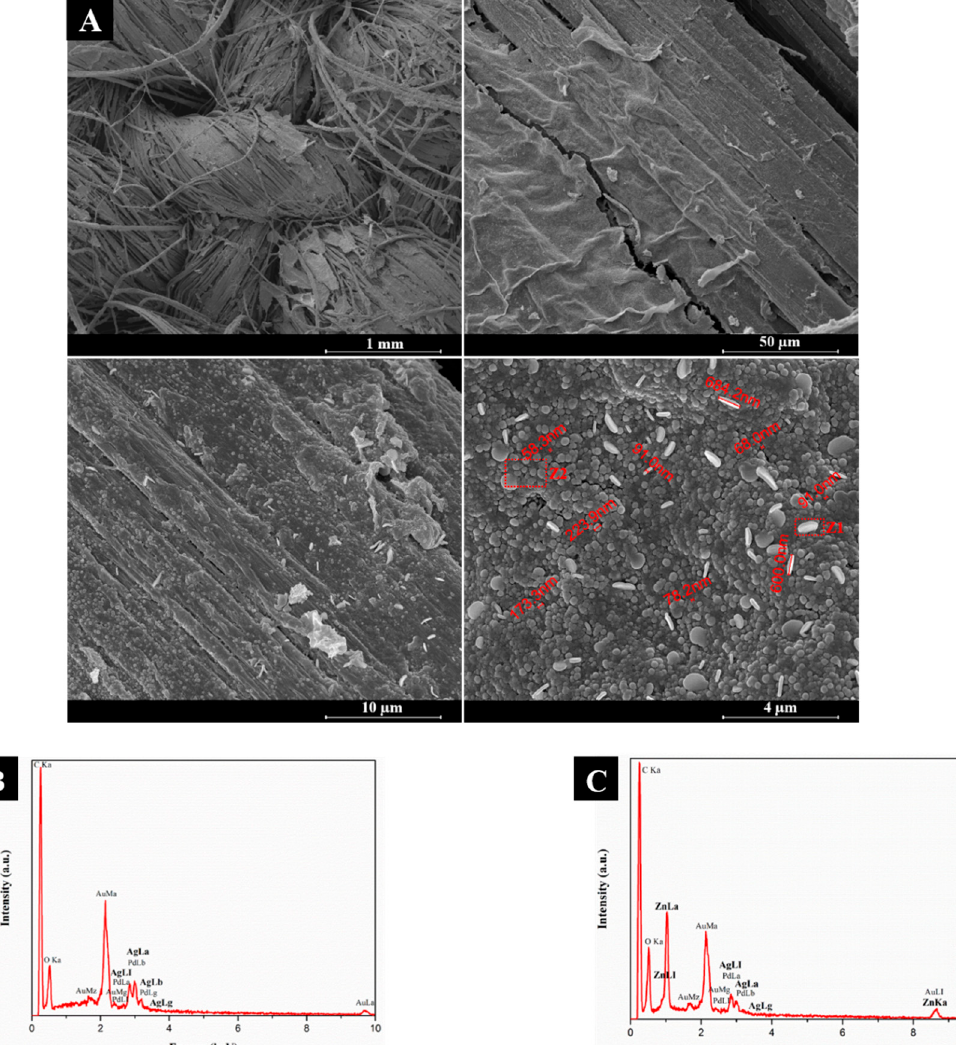
Figure 4. FESEM images of flax fabric functionalized with both AgNPs and ZnONPs ( A ). Magnifications of 1 mm, 50 µm, 10 µm, and 4 µm (from the left to the right). EDS spectra of Z1 zone ( B ) and Z2 zone ( C ).